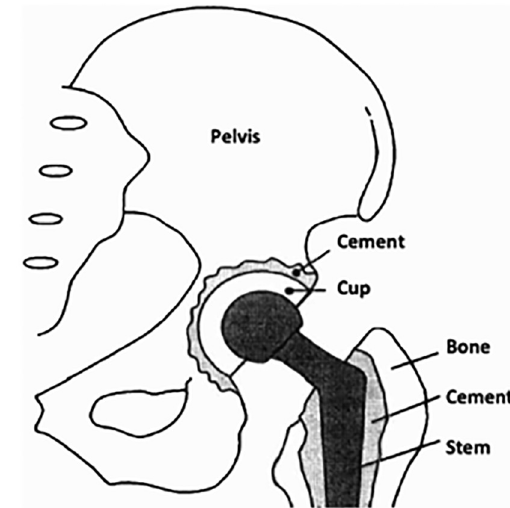
Figure 1: A schematic of a cemented acetabular replacement in a total hip replacement 22,23 .